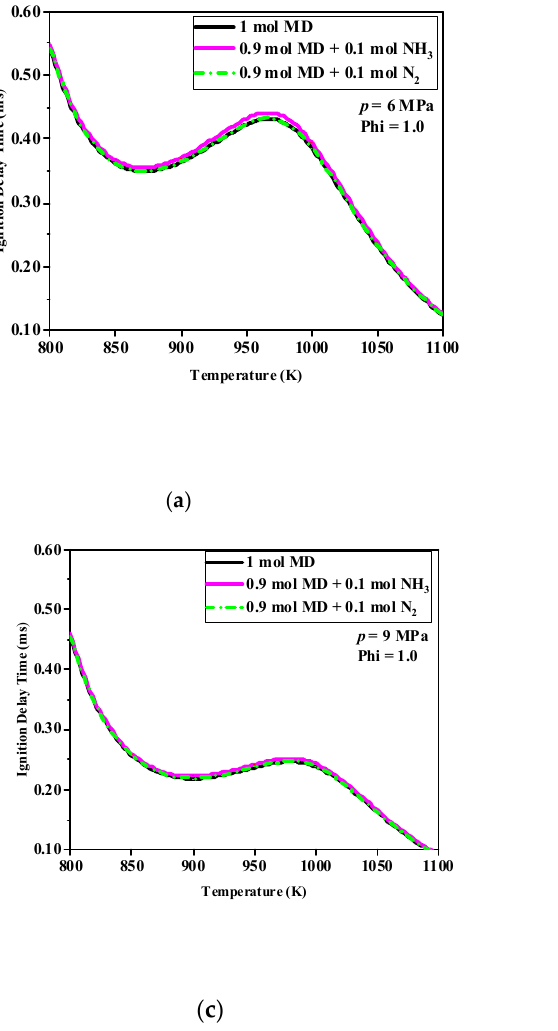
Figure 2. The IDT of each component at an initial temperature of 800–1100 K: ( a ) 1 mol MD, 0.9 mol MD + 0.1 mol NH 3 , and 0.9 mol MD + 0.1 mol N 2 at p = 6 MPa; ( b ) 1 mol MD, 0.8 mol MD + 0.2 mol NH 3 , and 0.8 mol MD + 0.2 mol N 2 at p = 6 MPa; ( c ) 1 mol MD, 0.9 mol MD + 0.1 mol NH 3 , and 0.2 mol N 2 at p = 9